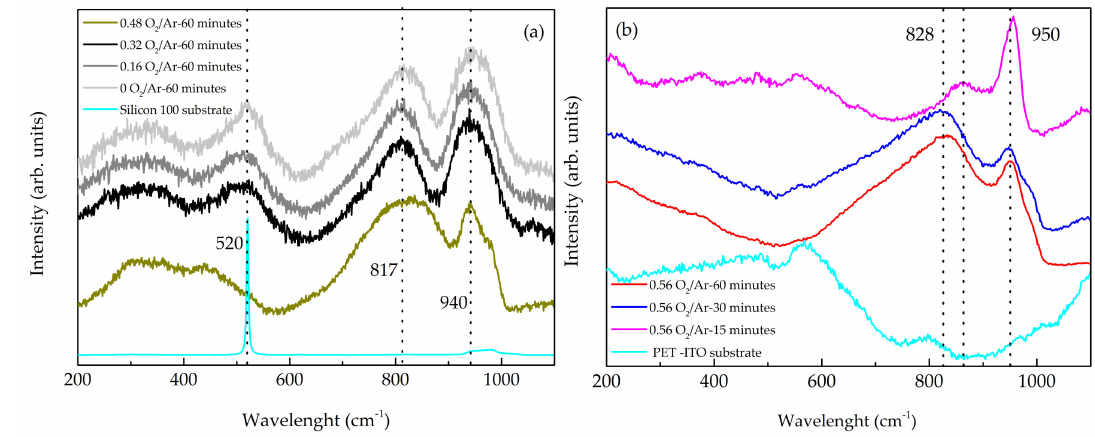
Figure 4. Raman spectra of the: ( a ) the first series of MoO x films grown at a different flow rate ratio of O 2 /Ar; ( b ) the second series of MoO x films deposited with a 0.56 flow rate ratio of O 2 /Ar and different deposition